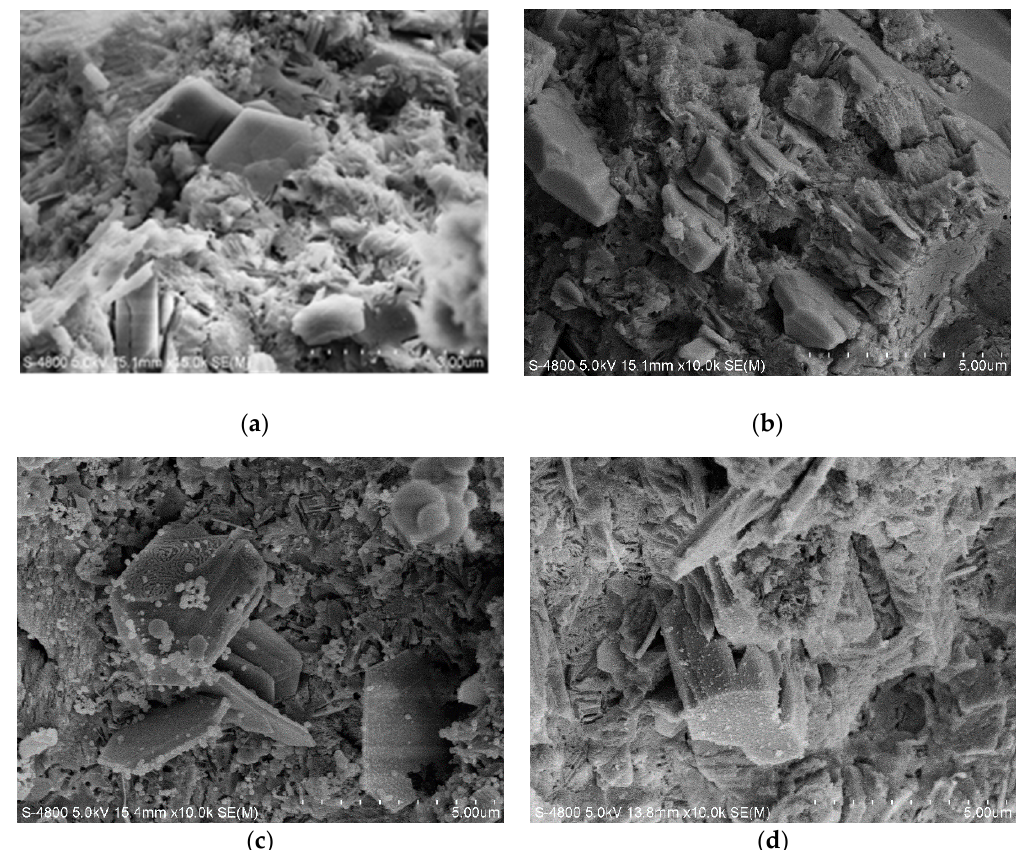
Figure 9. SEM images of cement pastes hydrated for 3 days. ( a ) 0%P 2 O 5 , ( b ) 0.5%P 2 O 5 , ( c ) 2.0%P 2 O 5 and ( d ) 2.5%P 2 O 5.